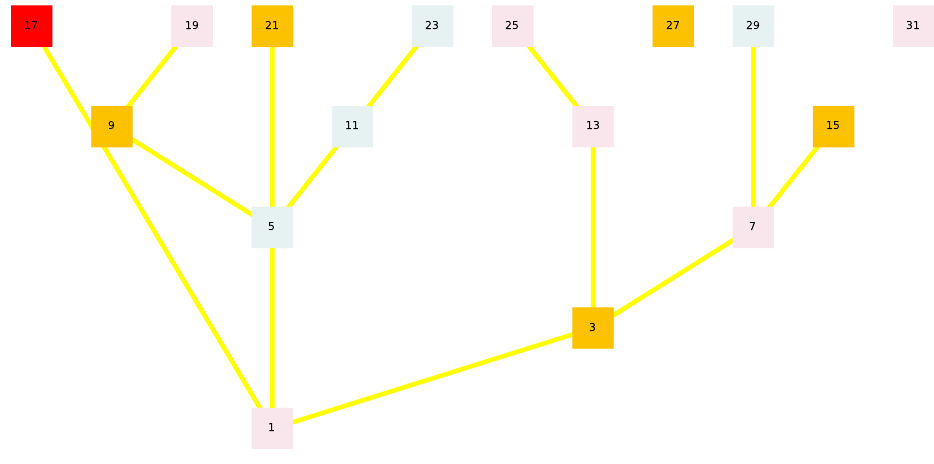
Figure 18. Golden Automaton confined to numbers smaller than 32 [42].